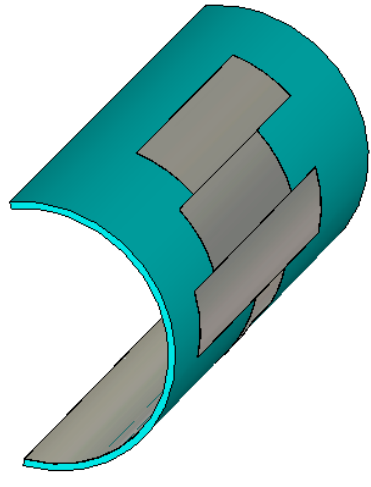
Figure 12. Proposed antenna in a bending condition (upside-down).